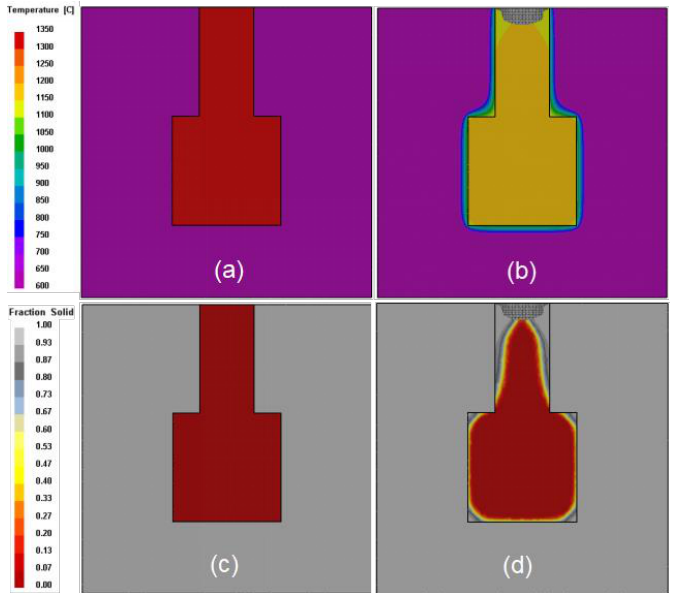
Figure 3. Solidification progress and riser top state of prototype A1 poured at 1350 °C: ( a ) Initial temperature of casting, 1350 °C; ( b ) Casting temperature and riser top dropped significantly; ( c ) Initial solid rate of casting, 0%; ( d ) Solid fraction distribution when riser top solidified.